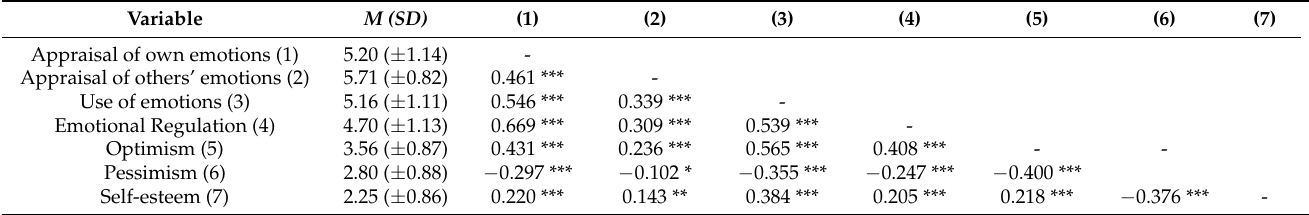
Table 2. Internal consistency, mean, standard deviation and Spearman’s correlation.